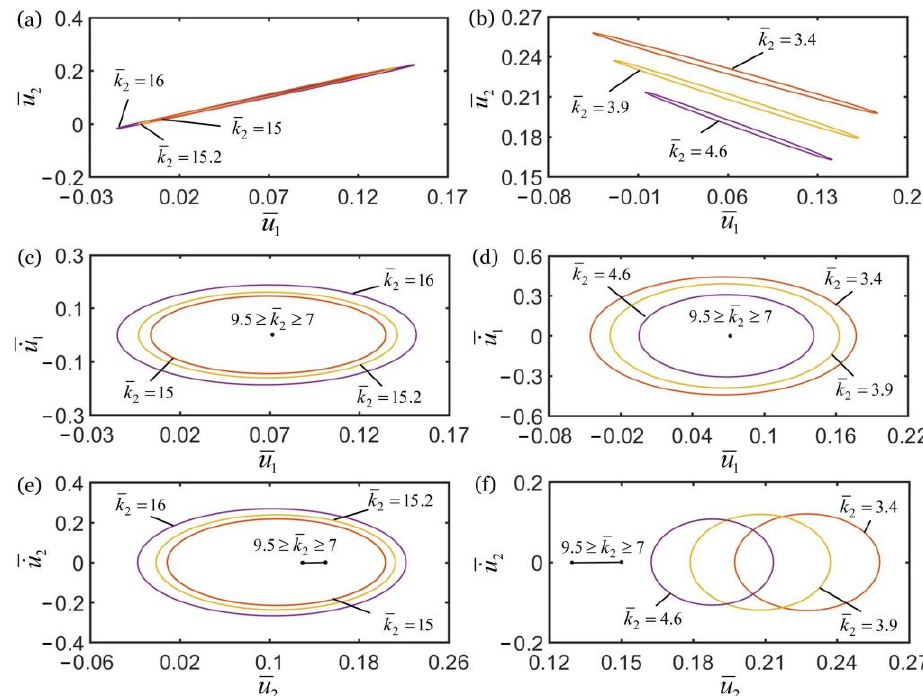
Figure 7. The effect of spring constant k 2 on the self-oscillations of two coupled oscillators. In the computation, the other geometric and material parameters are given in Table 2. ( a ) Domain of attraction, and ( c , e ) limit cycles for in-phase regimes of k 2 > 9.5. ( b ) Domain of attraction, and ( d , f ) limit cycles for anti-phase regimes of k 2 < 7. The synchronous regime of self-oscillations of two oscillators is mainly determined by the spring constant.